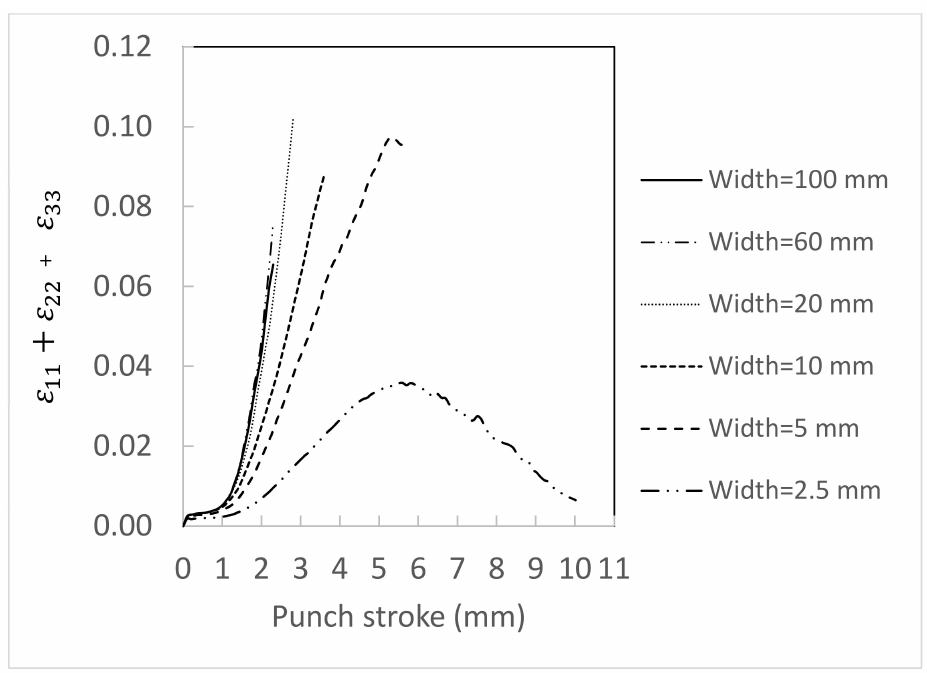
Figure 8. Volumetric strain in metal sheets with various